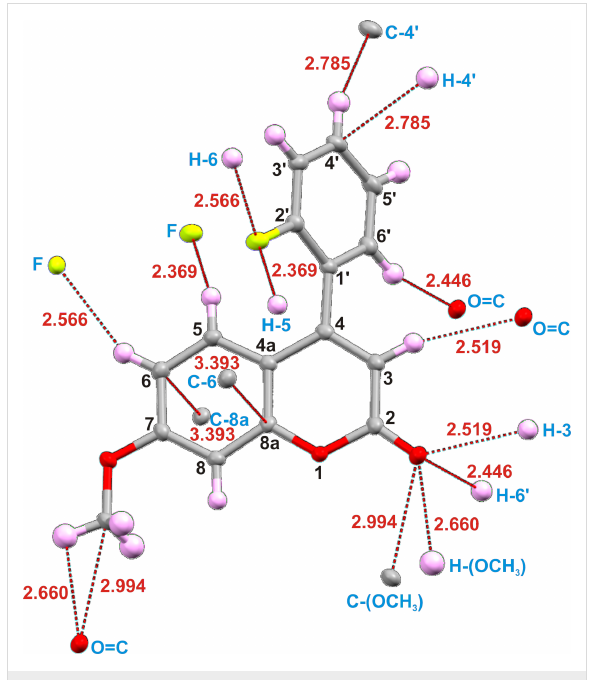
Figure 7: Short contacts within the single-crystal X-ray structure of coumarin 6 .